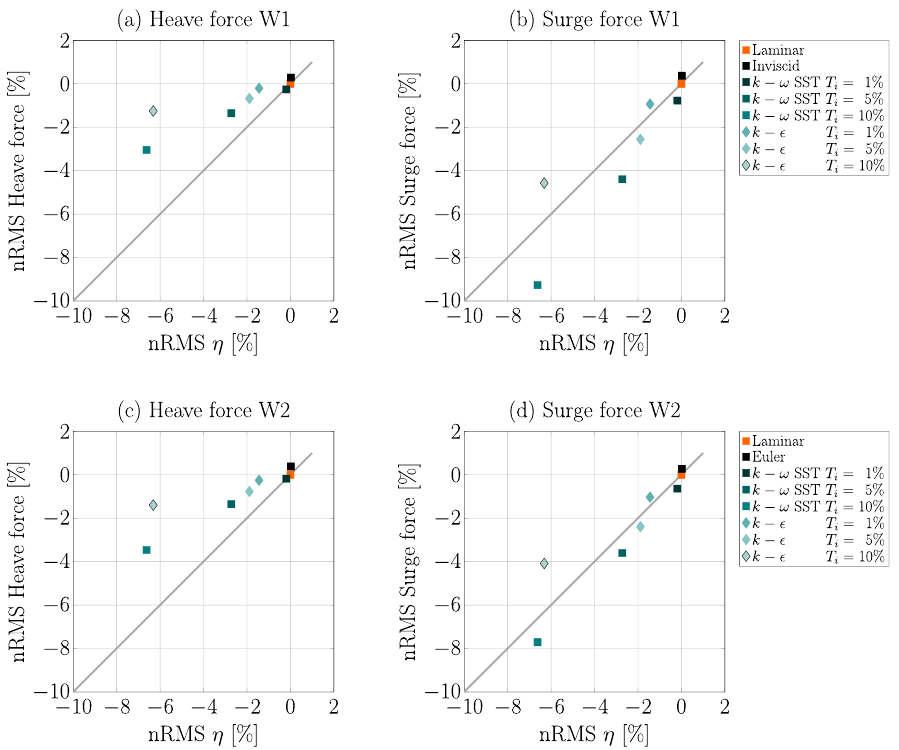
Figure 8. nRMS of the heave and surge wave excitation forces over the nRMS of the free surface elevation for ( a , b ) W1 and ( c , d ) W2.